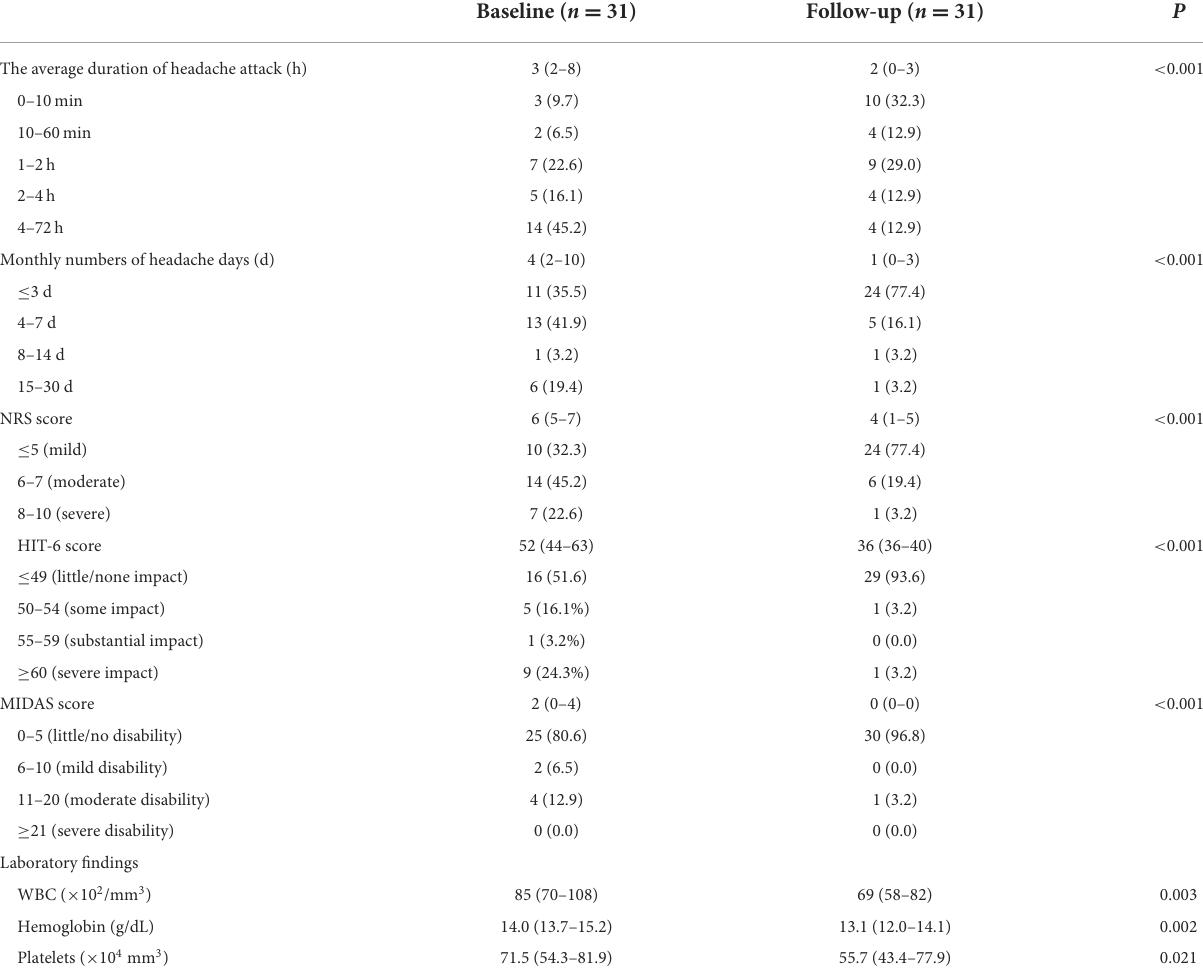
TABLE 5 Comparison of parameters for headache and laboratory findings at baseline and